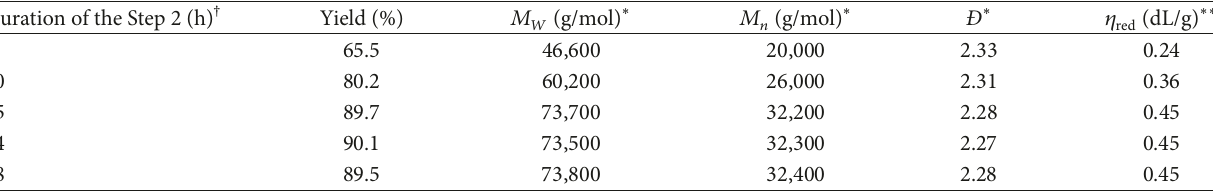
Table 10: The influence of the reaction duration on the characteristics of